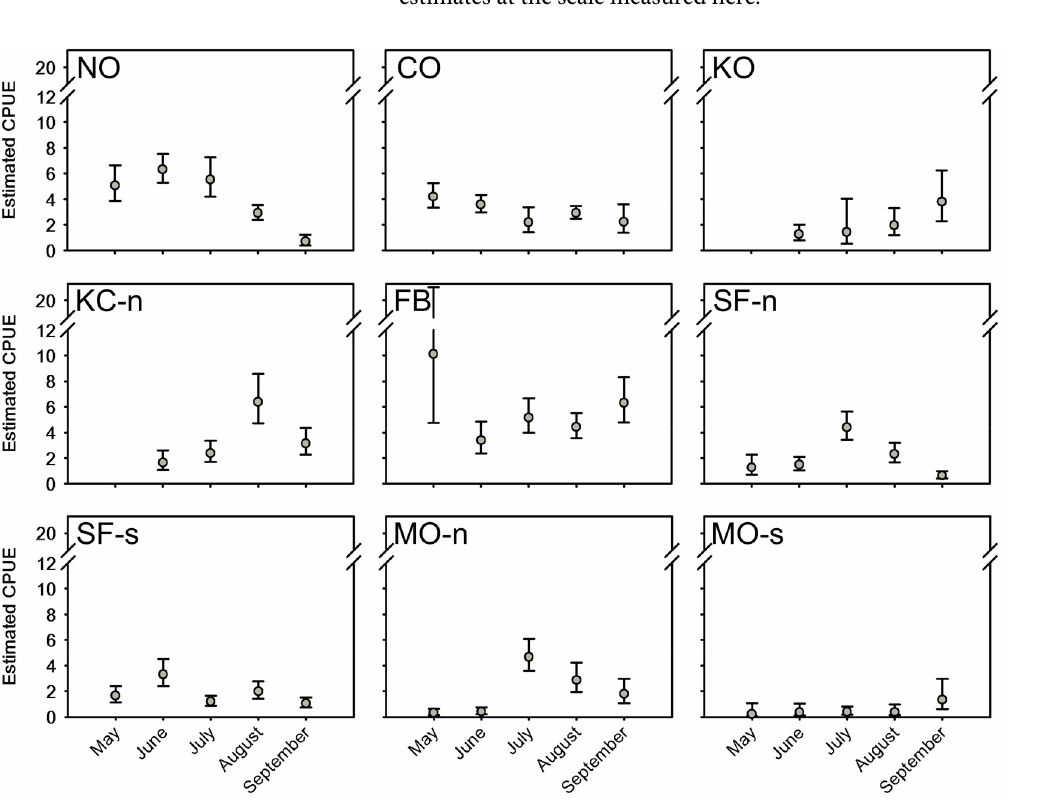
to 0.0488) and lower for 22 (uncorrected p-values 0.0000 to 0.0400), relative to the arbitrarily set reference required by the model. The modest differences among fisherman CPUE suggests that differences among fisherman ability has limited consequences for CPUE-based abundance estimates at the scale measured here.